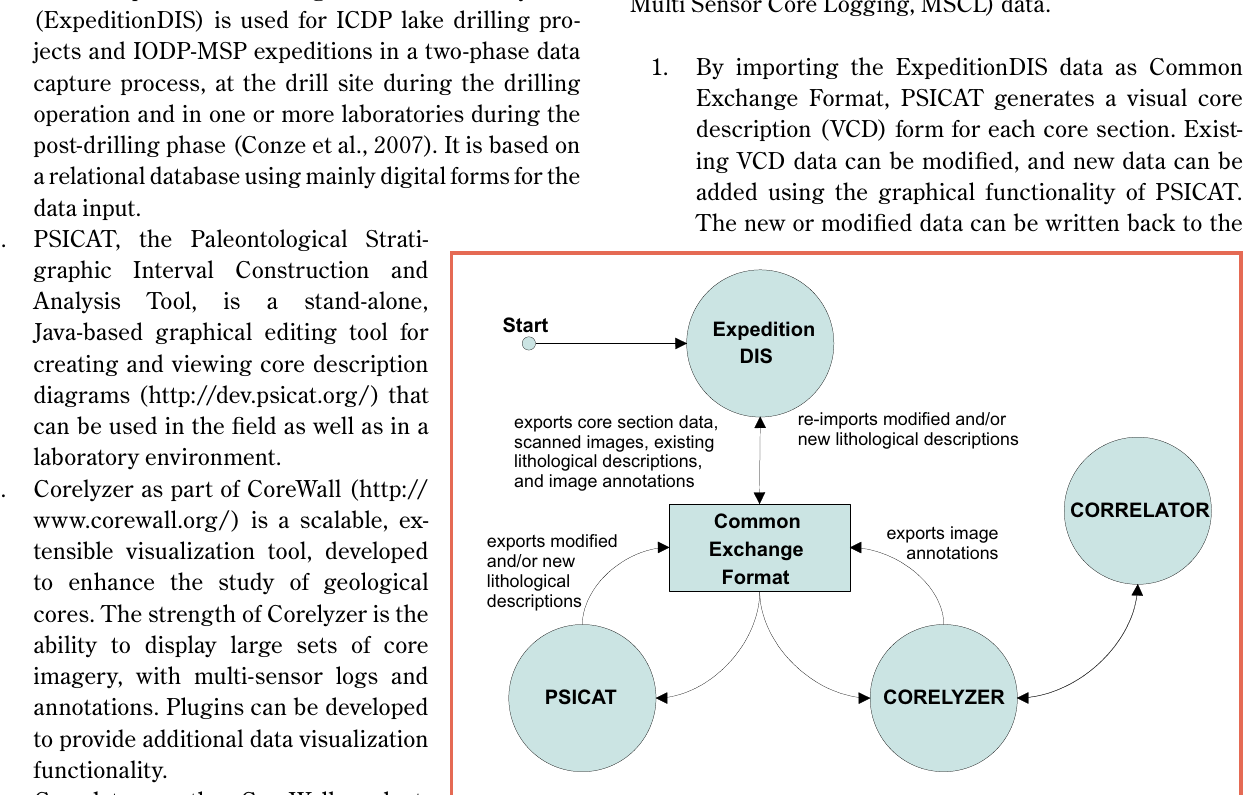
Figure 1. Conceptual diagram showing data exchange between the components (Figure credit by R.